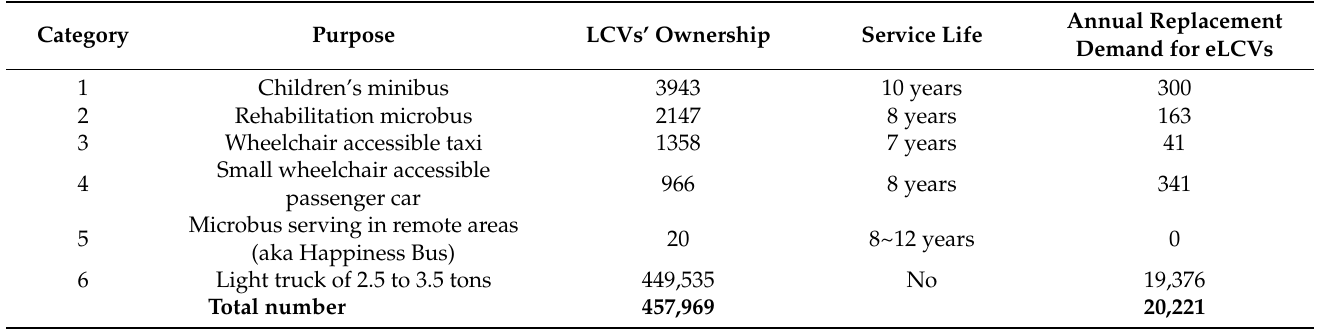
Table 1. Potential demand for eLCVs in